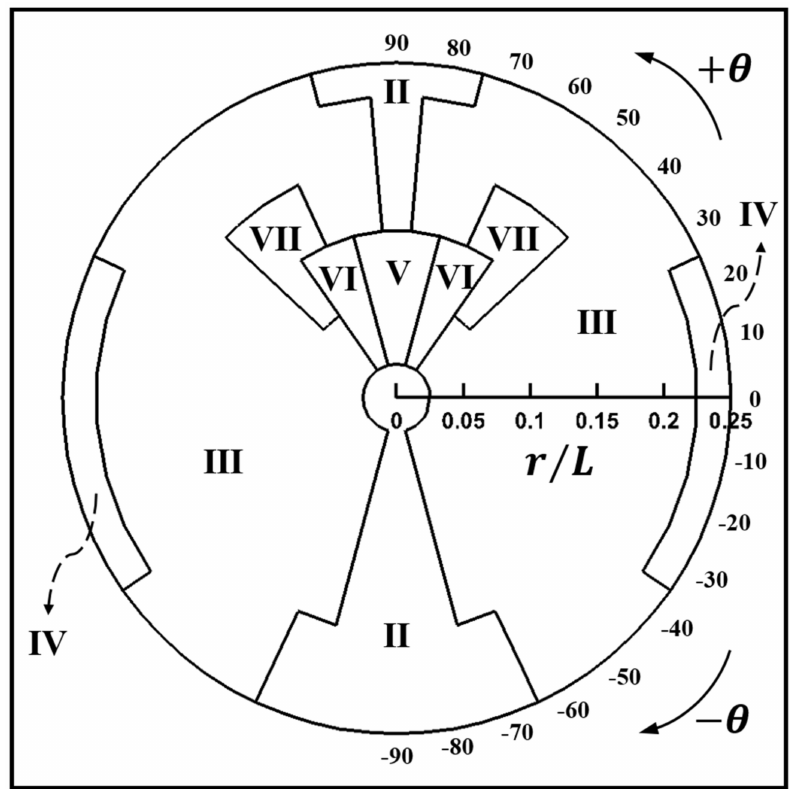
Figure 13. Map of the flow structure for Ra = 10 5 .